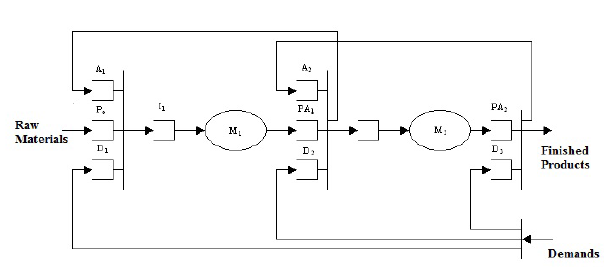
Figure 2. Extended Kanban modeled as a queue type system